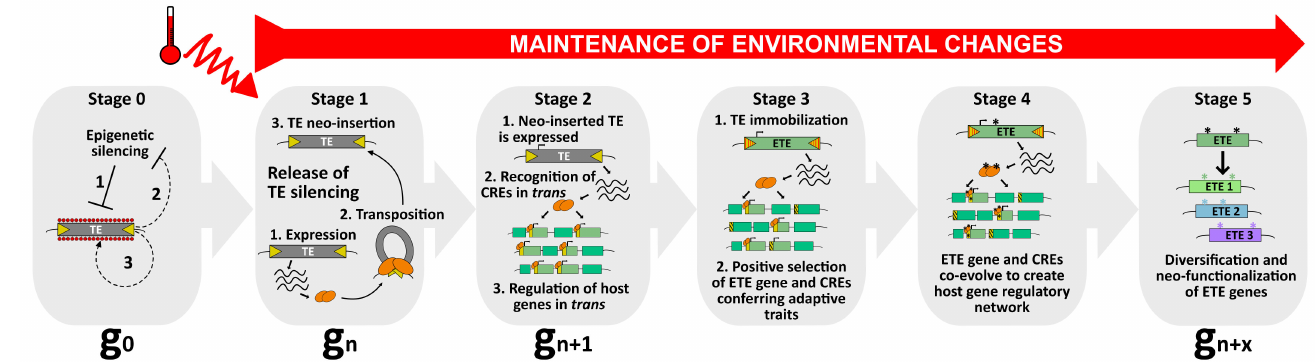
Figure 2. A model to explain the occurrence of TE exaptation. This hypothetical model describes the exaptation of a class II TE-derived transposase. At stage 0, TEs are repressed by silencing pathways to ensure host genome integrity (1). Nevertheless, as purifying selection and genetic drift negatively impact the transgenerational persistence of TEs within the host genome, these latter might use anti-silencing strategies (2) to maintain some basal level of activity (3), and to be inherited as functional elements. Among the pool of TEs, one of them can be considered as an ETE precursor. At stage 1, upon, for instance, the perception of an environmental stimulus, such as heat, this TE is activated. As a young and functional element, it can transpose and mobilize in new genomic regions (neo-insertions). At stage 2, the neo-inserted TE is expressed, producing transposase proteins that will recognize TE-derived CREs genome-wide and potentially recruit additional chromatin factors to regulate host genes in trans . At this stage, although the neo-inserted TE is still capable of mobilization, it can enter selective pressure when providing positive advantage to the host. However, this feature must be followed by a swift transition to stage 3, in which the neo-inserted TE becomes immobilized. At stage 3, the neo-inserted TE is immobilized by mutations occurring in its TIRs (red stripes), turning into an ETE gene. Undoubtedly, TE immobilization is essential in the process of TE exaptation. Although TE immobilization is an absolute prerequisite for TE exaptation, it is not sufficient. ETE genes must remain stably expressed, most likely because environmental conditions persist. The ETE gene still undergoes positive selection and CREs that are not conferring adaptive traits are negatively selected. At stage 4, ETE gene and CREs co-evolve, accumulating mutations (*) under purifying selections, and together create a new host gene regulatory network that will be perpetuated only if the environmental changes persist. At stage 5, the ETE gene can be considered a genuine host gene, providing phenotypic value. Following relaxed selection pressure, the TE-derived sequence may inherit point mutations (*), or gene duplication may occur. ETE diversification and neo-functionalization ensure “long-term” positive adaptation of ETE sequence to ultimately create genetic variants with new cellular